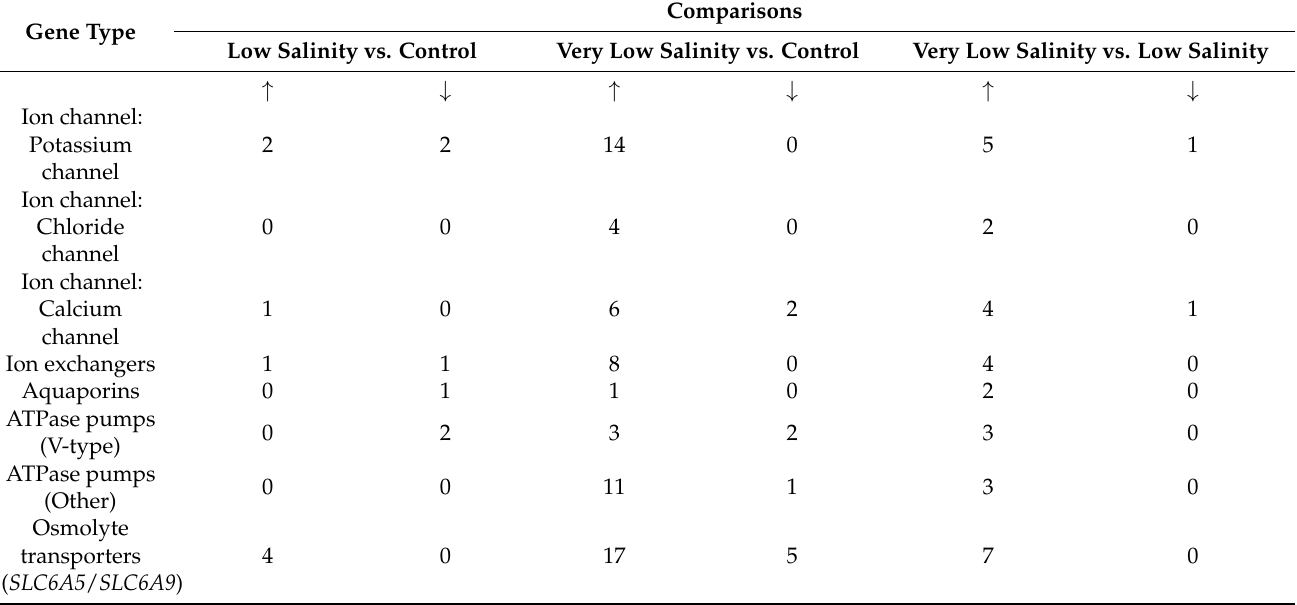
Table 3. Osmoregulatory marker genes identified in the differentially expressed profiles from low salinity exposure treatment comparisons, using the SwissProt annotations (see Spreadsheet S2 for gene transcript lists). ↑ : represents upregulated genes, ↓ : represents downregulated